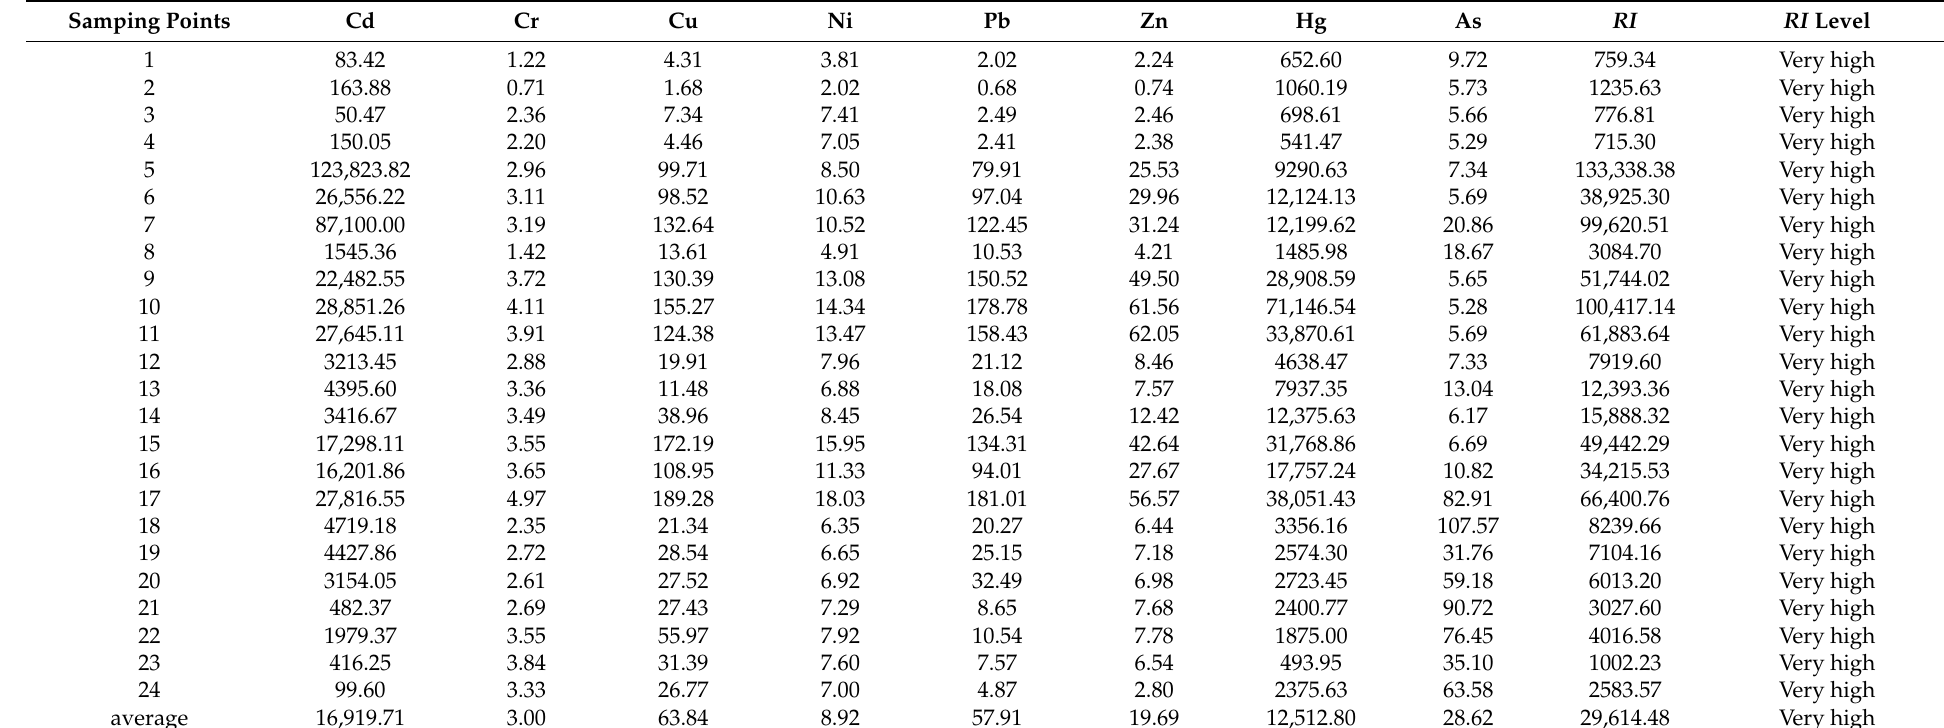
Table 5. The potential ecological risk indexes of heavy metals in sediments from the Huafei River.